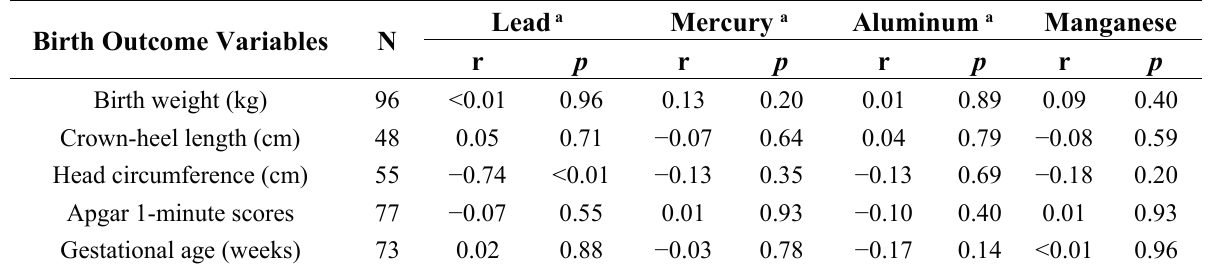
Table 5. Correlation coefficients (r) between cord blood metal concentrations and birth outcome